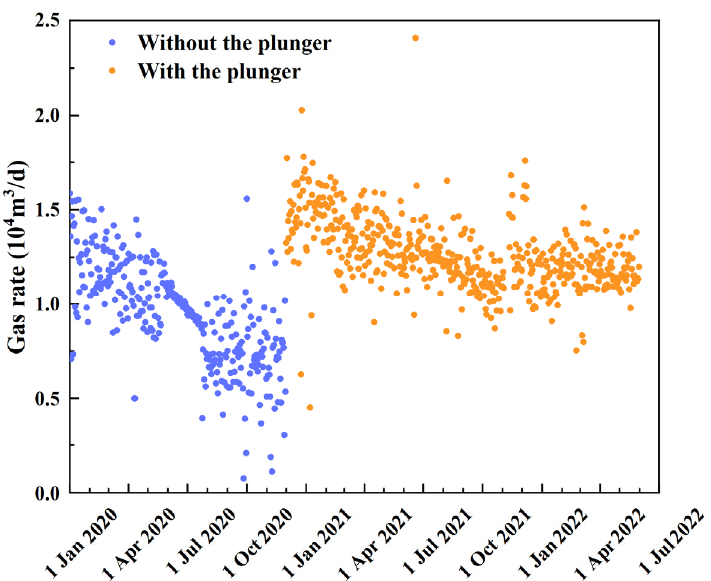
Figure 3. Production data of well X1 in the Su 59 area. Table 1. Basic data of X1 well in Su 59